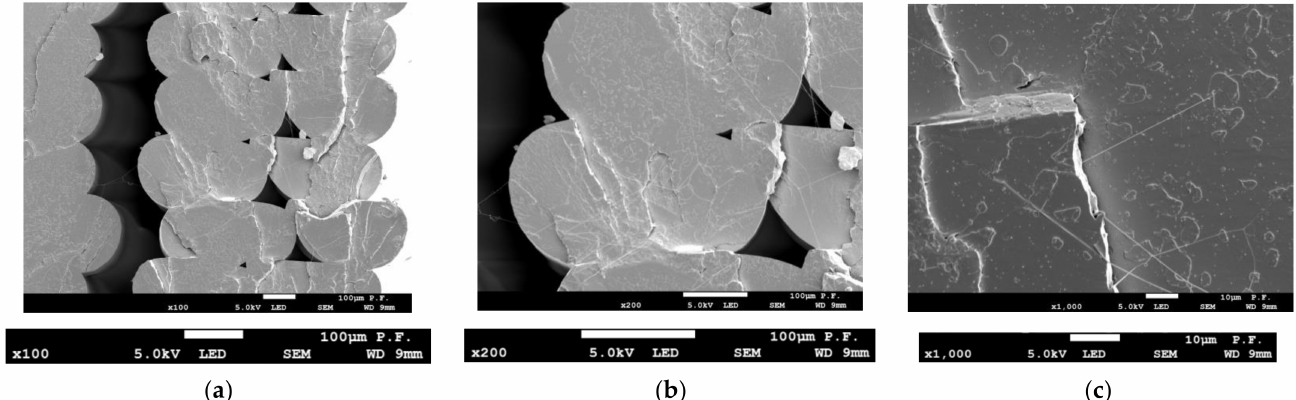
Figure 16. Cross-sectional views of a 1.8 mm thick PLA specimen after failure, ( a ) voids in the material and a gap between the layers, × 100 magnification; ( b ) × 200 magnification, ( c ) microcracks in a single filament, × 5000